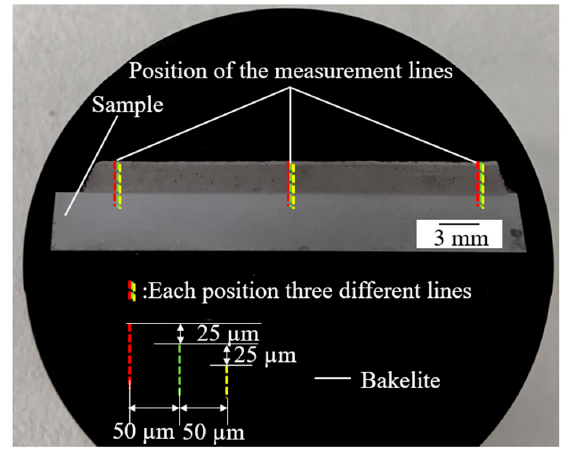
Figure 6. Arrangement of measurement points for Vickers hardness testing.